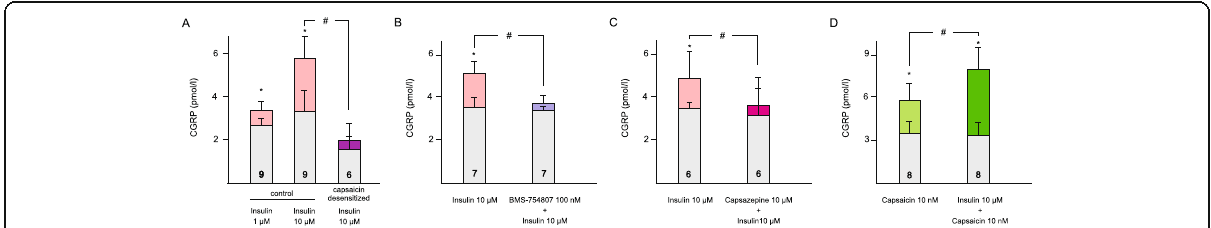
Fig. 1 Change in CGRP release in the hemisected skull preparation. ( A ) CGRP concentrations measured in control rats after topical applications of insulin at 1 μ M and 10 μ M and in capsaicin desensitized animals at 10 μ M. ( B ) CGRP releasing effect of insulin at 10 μ M before and after insulin receptor antagonist (BMS-754807 at 100 nM). ( C ) CGRP releasing effect of insulin at 10 μ M before and after TRPV1 receptor antagonist capsazepine (10 μ M). ( D ) CGRP releasing effect of capsaicin at 10 nM before and after the application of insulin (10 μ M). Light grey bars indicate the basal release, coloured bars indicate the stimulated CGRP release in the same preparation. The number of measurements is indicated in the bars. *: statistically different from the basal CGRP release. #: statistically different from the control or the effect without